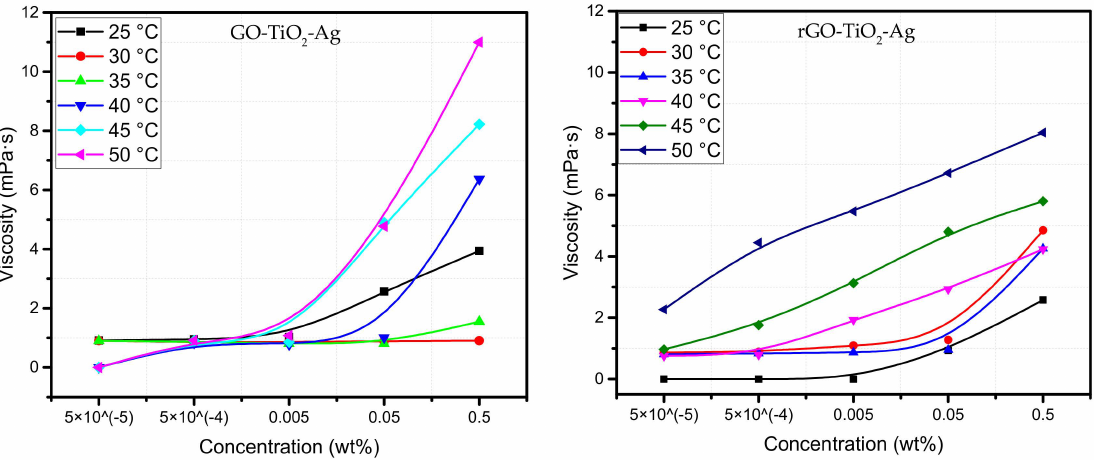
Figure 3. Viscosity vs. concentration at different temperatures of ternary hybrid